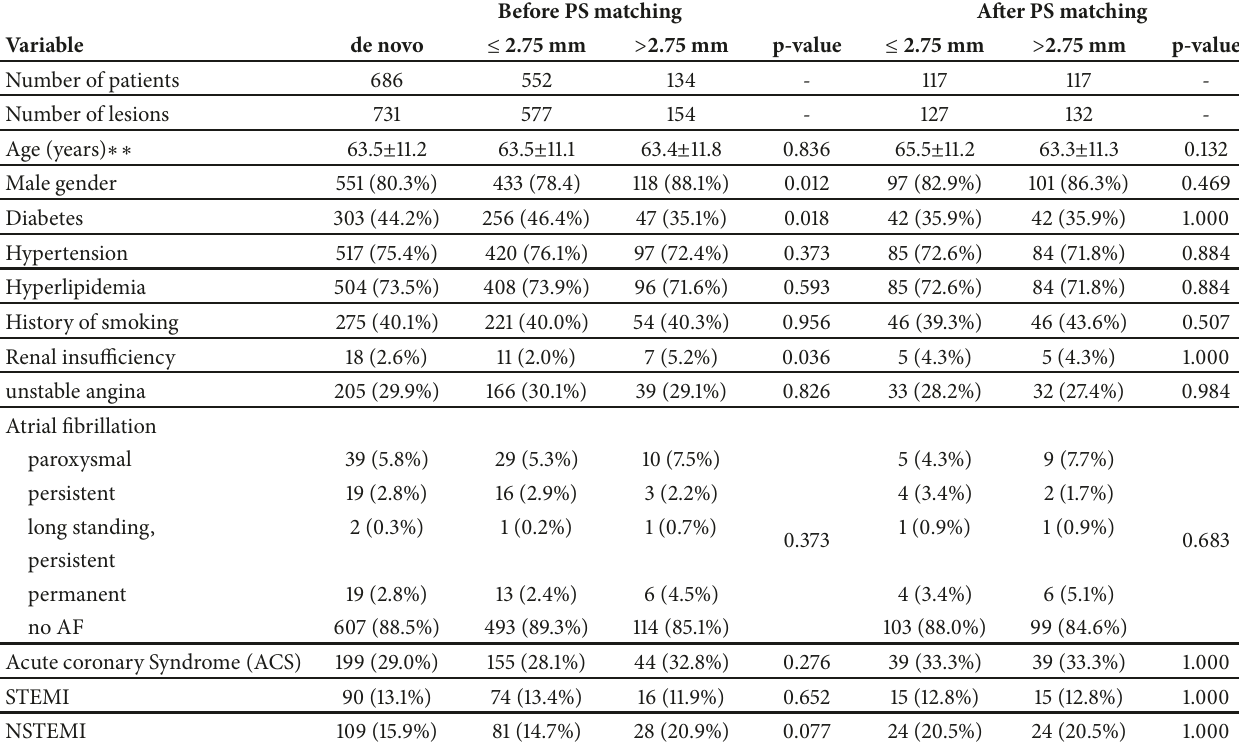
Table 1: Patient